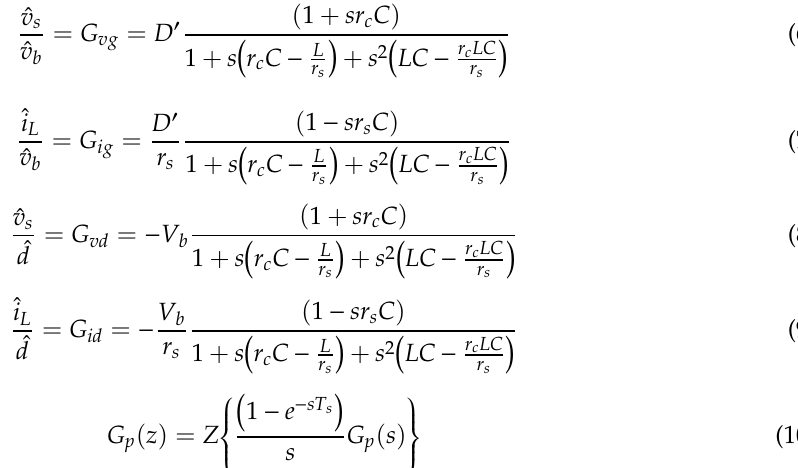
Figure 9. Small-signal block diagram for two-loop control.